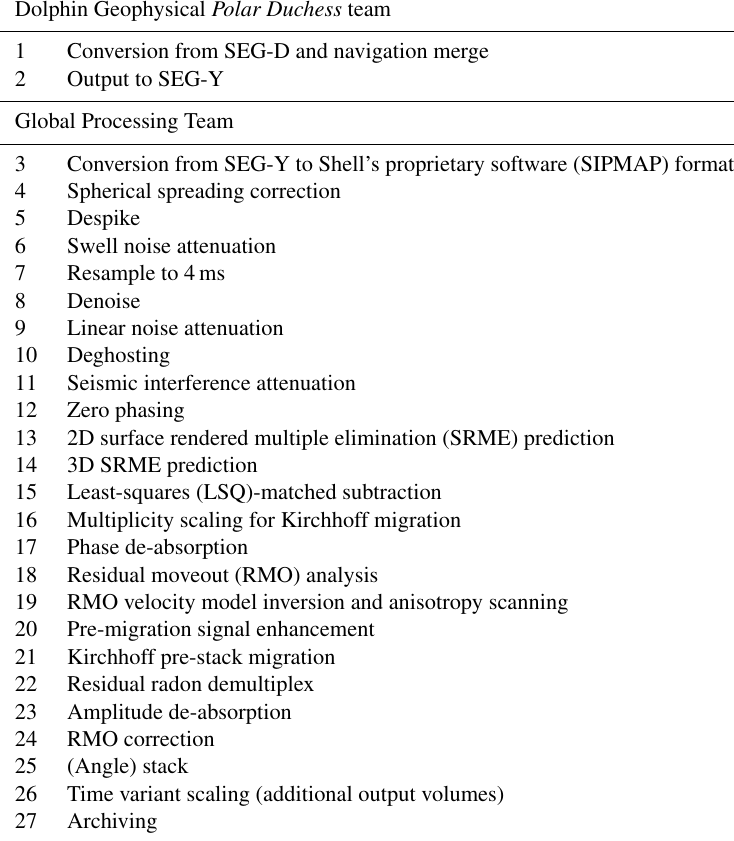
Table 2. Processing workflow of the seismic survey (Kramer and Heck, 2014). Dolphin Geophysical Polar Duchess team 1 Conversion from SEG-D and navigation merge 2 Output to SEG-Y Global Processing Team 3 Conversion from SEG-Y to Shell’s proprietary software (SIPMAP) format 4 Spherical spreading